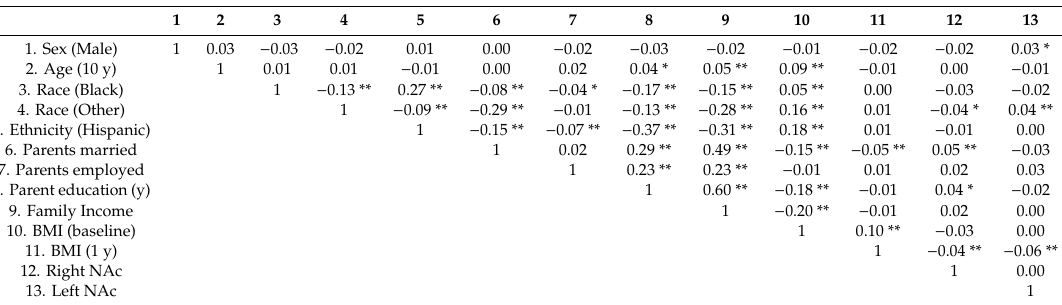
Table 2. Correlations in the total sample.